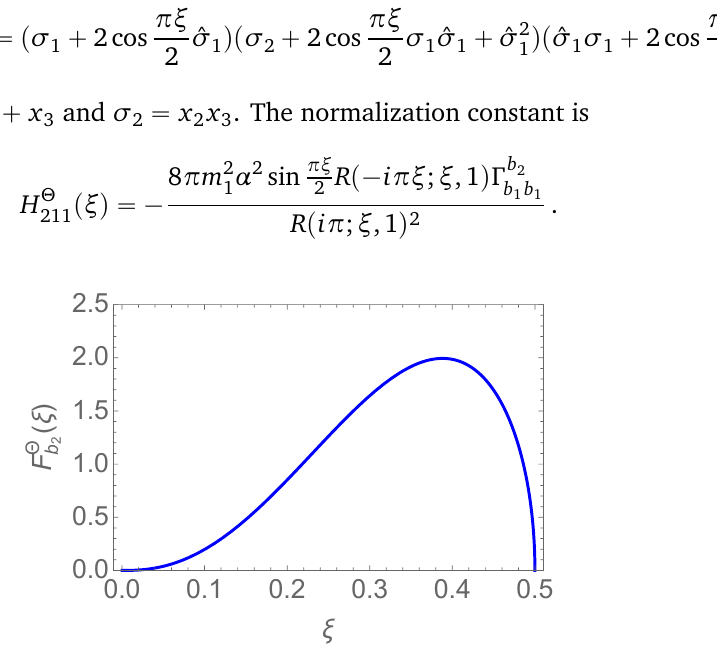
Figure 4: The one particle form factor F Θ